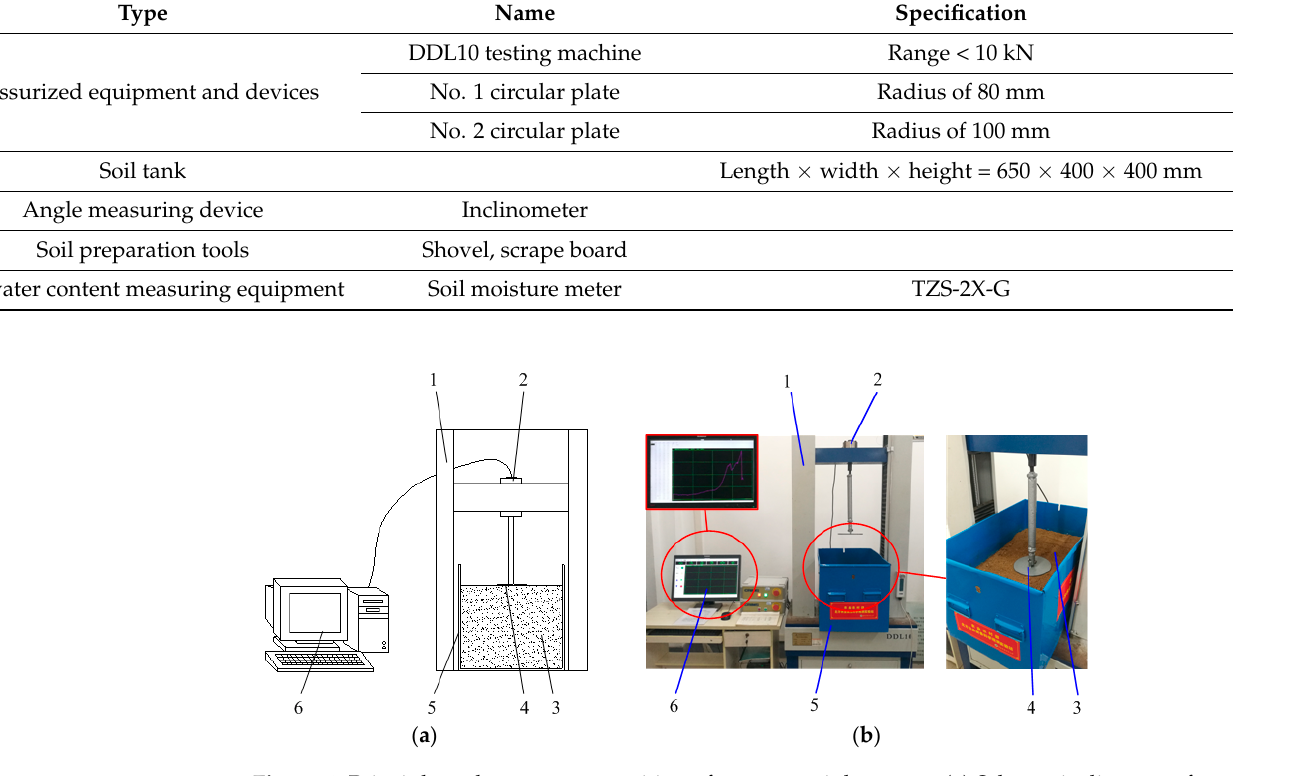
Figure 4. Principle and system composition of pressure–sinkage test. ( a ) Schematic diagram of test principle; ( b ) System composition; 1. Testing machine; 2. Pressure sensor; 3. Soil; 4. Circular plate;